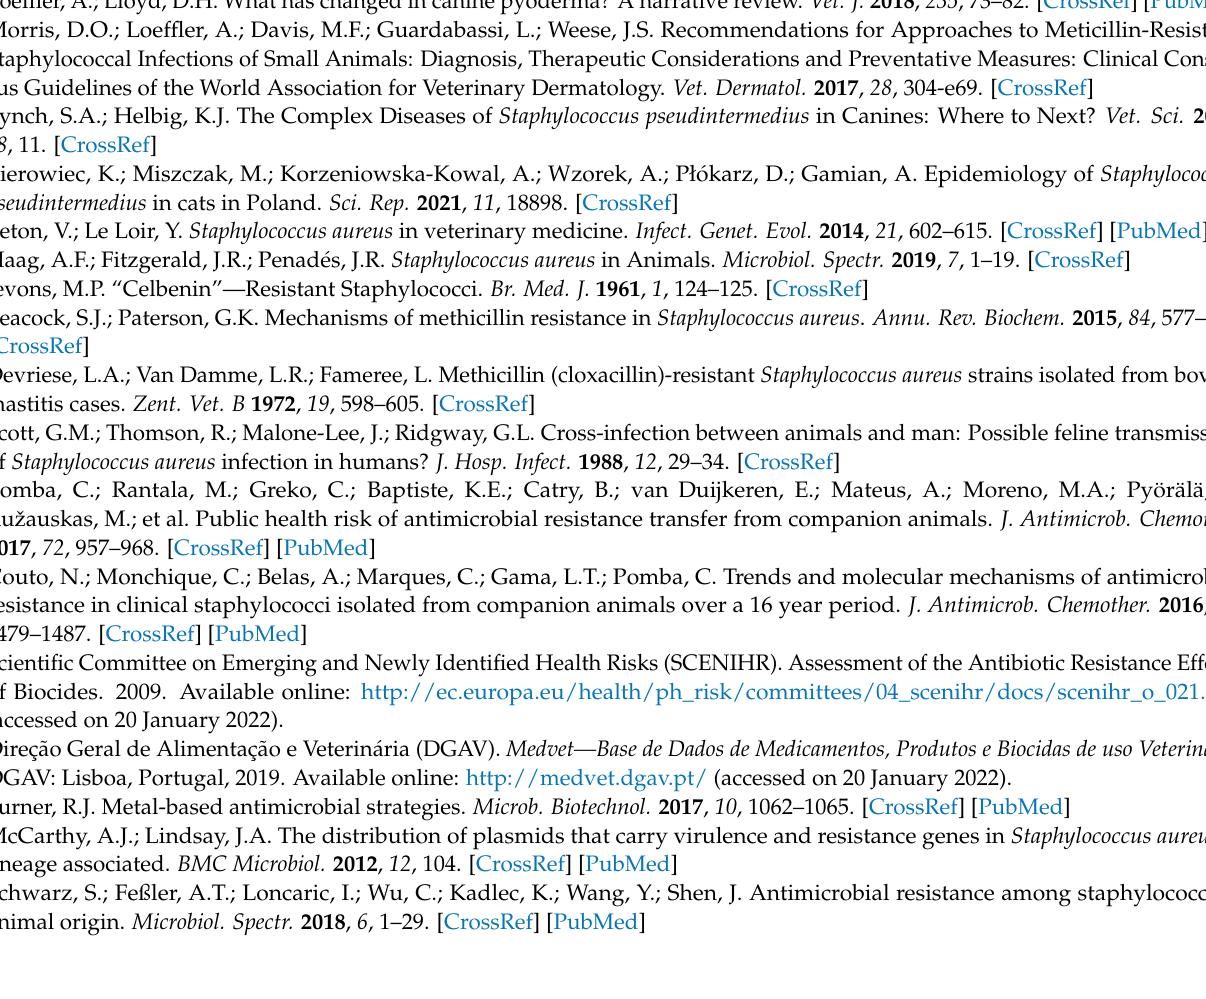
Table S3: Primers used in this study. References [12,23,29,34,40,54,62,63,66–84] are cited in the supplementary